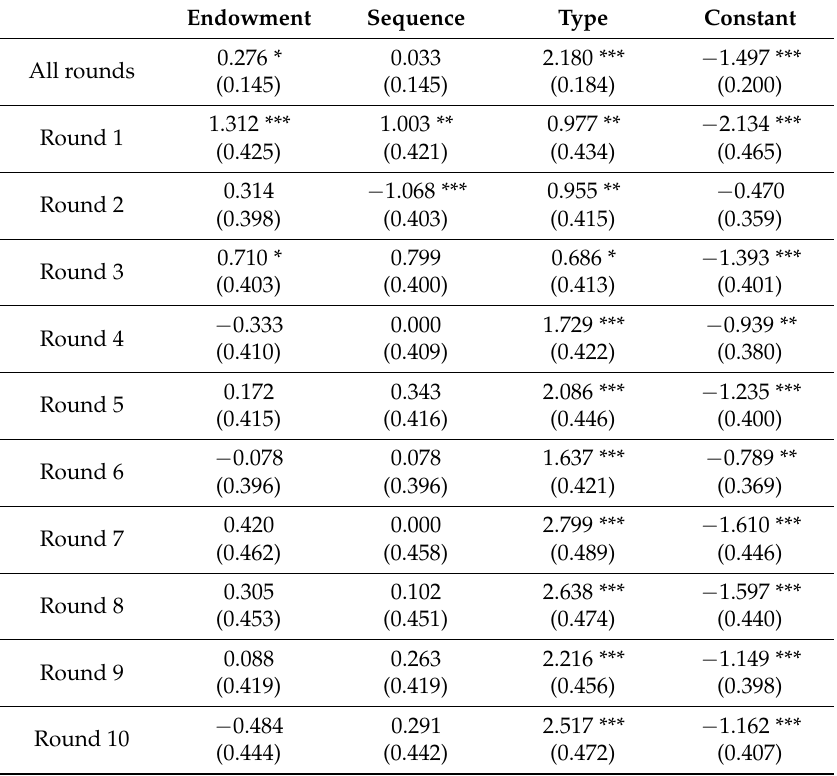
Table 4. Logistic regression